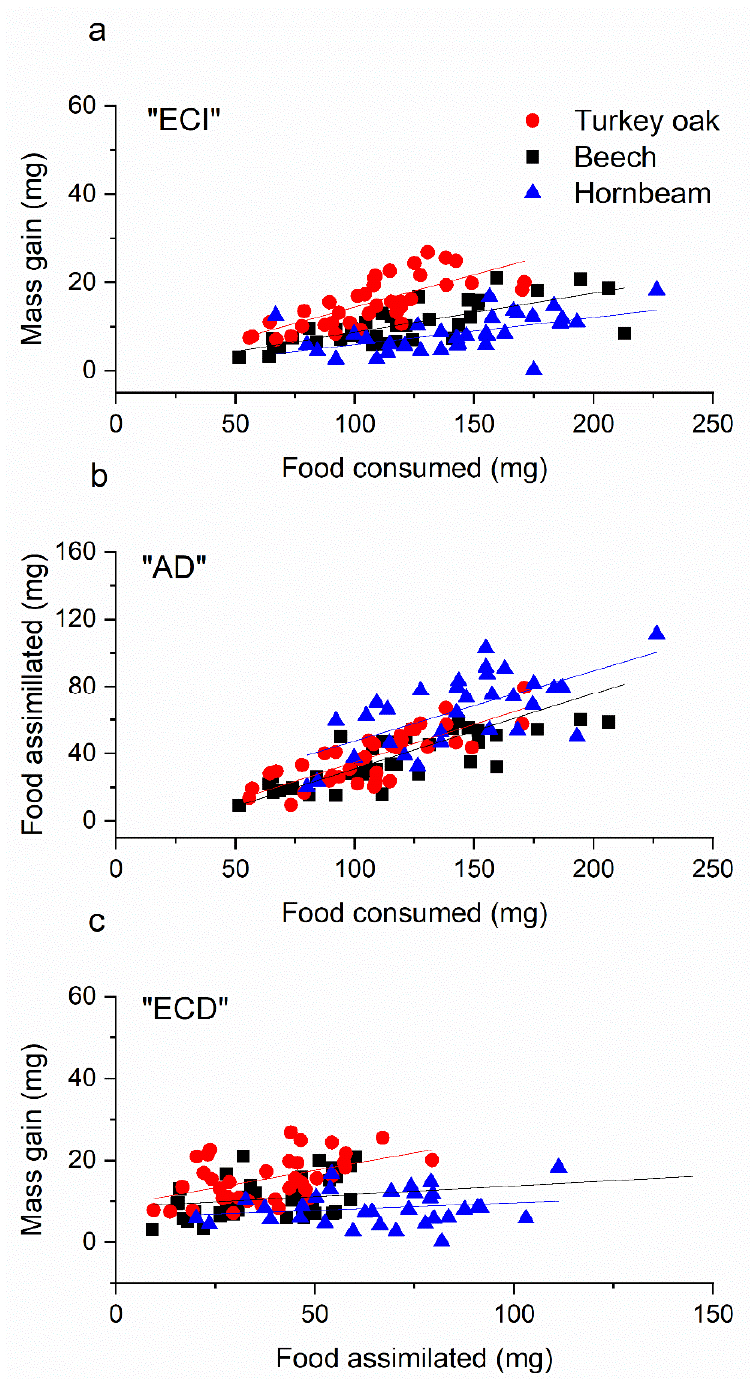
Figure 2. Bicoordinate plots of ANCOVA on mass gain against amount of consumed food ( a ), amount of assimilated food against amount of consumed food ( b ) and mass gain against amount of assimilated food ( c ).